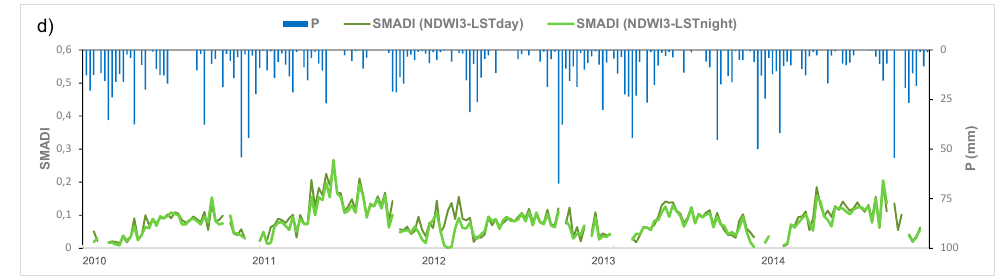
Figure 3. SMADI results at the REMEDHUS scale for ( a ) NDVI; ( b ) NDWI1; ( c ) NDWI2 and ( d ) NDWI3 versions.